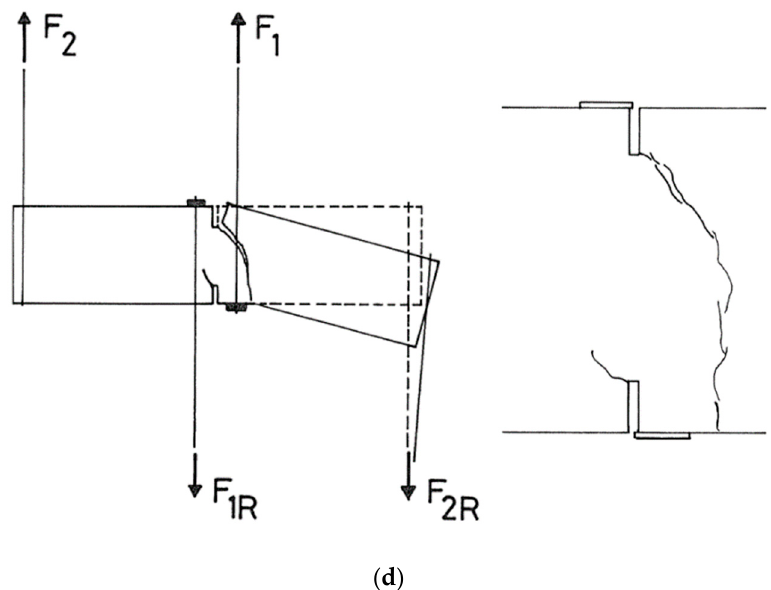
Figure 12. ( a ) Crack pattern for fixed supports in numerical analysis, the deformation is enlarged for better observation, ( b ) crack pattern for fixed supports in the experiment [32]. Reproduced from [32]. Copyright 1993, Delft University of Technology. ( c ) crack pattern for freely rotating in numerical analysis, the deformation is enlarged for better observation (red-cracked element; deformations have been scaled for clarity), ( d ) crack pattern for freely rotating in the experiment [32]. Reproduced from [32]. Copyright 1993, Delft University of Technology.